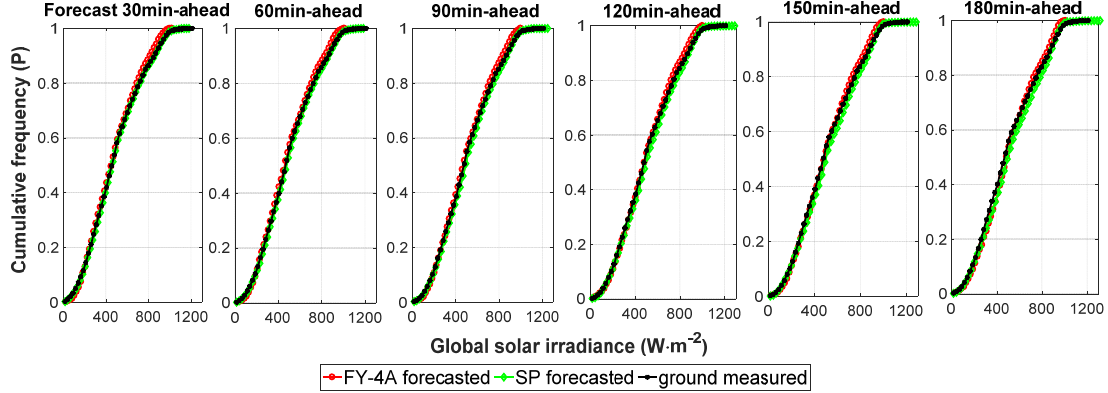
Figure 9. The GHI cumulative frequency curves for the time horizons from 30 to 180 min.